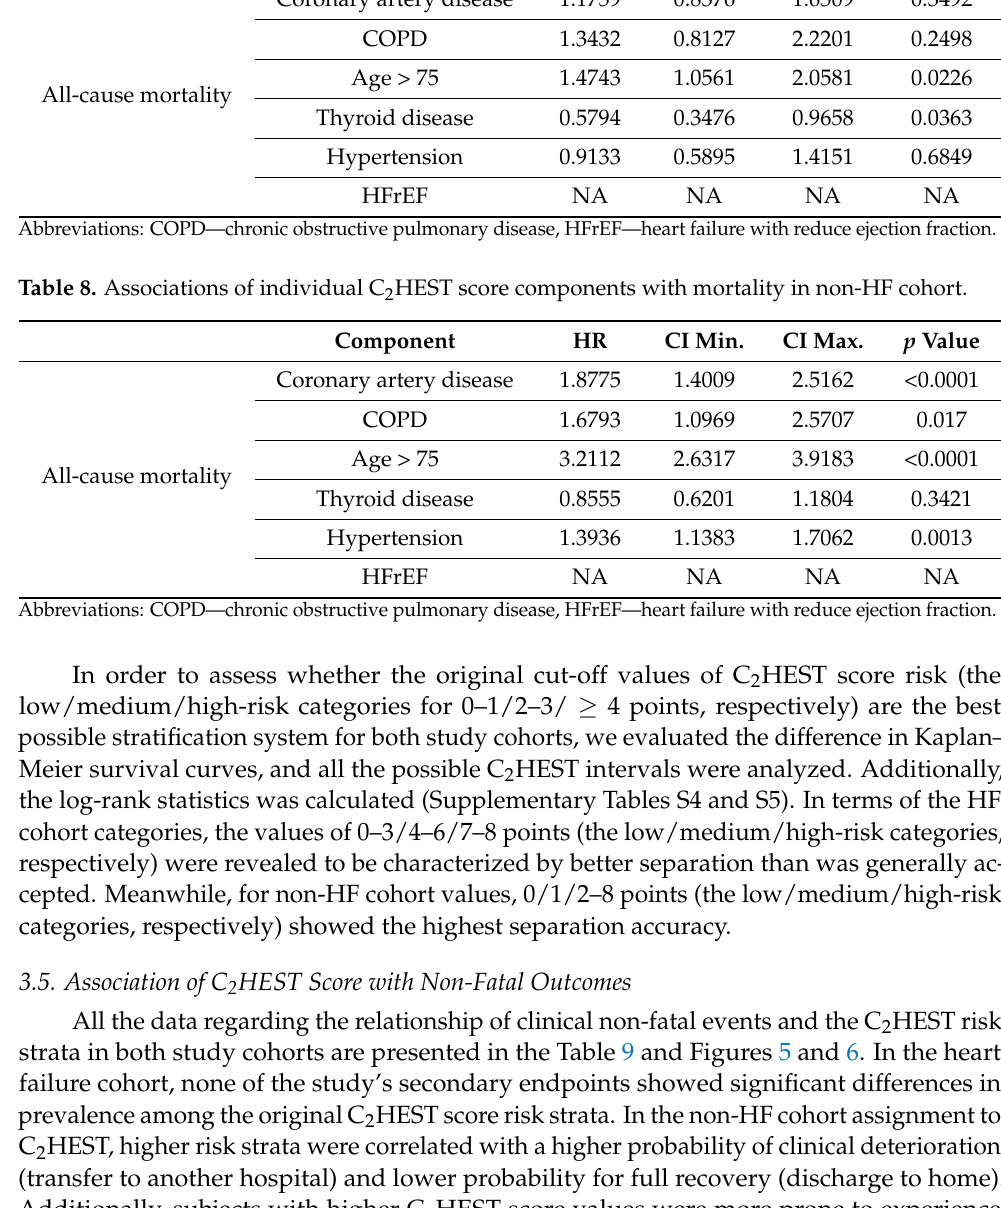
Table 7. Associations of individual C 2 HEST score components with mortality in the HF cohort. Component HR CI